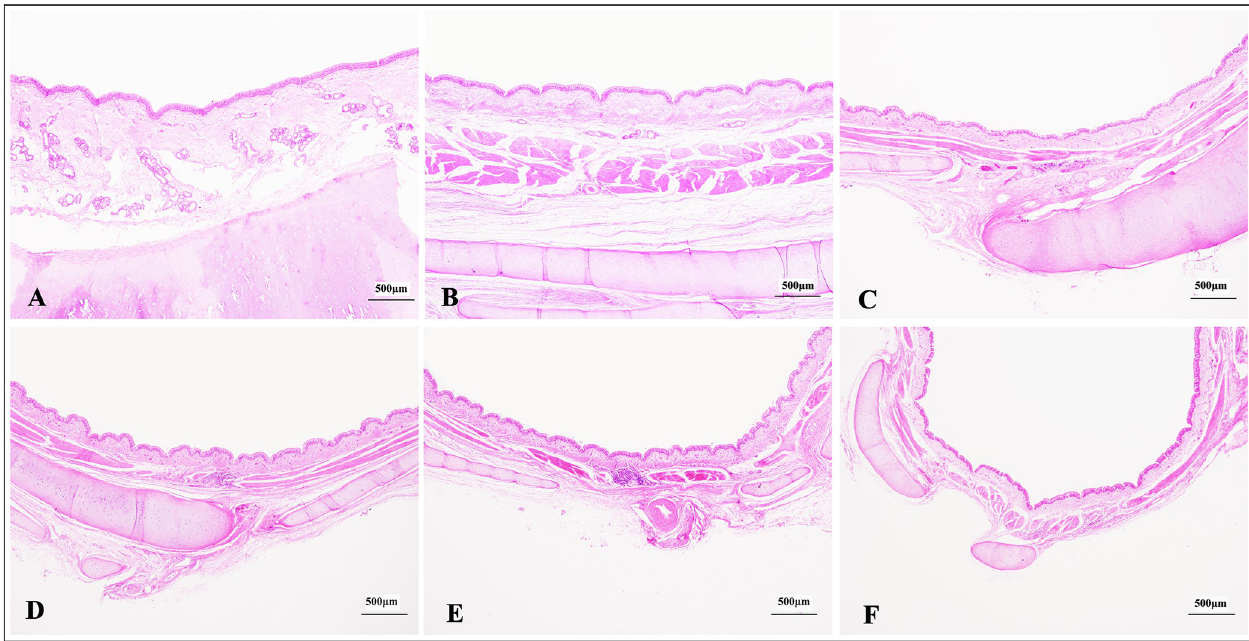
Fig 1. Histological characteristics of the different graded bronchi in Bactrian camels.